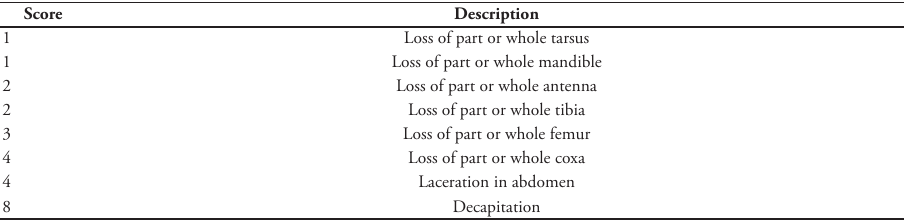
Table 1. Criteria used in scoring injuries of male fig